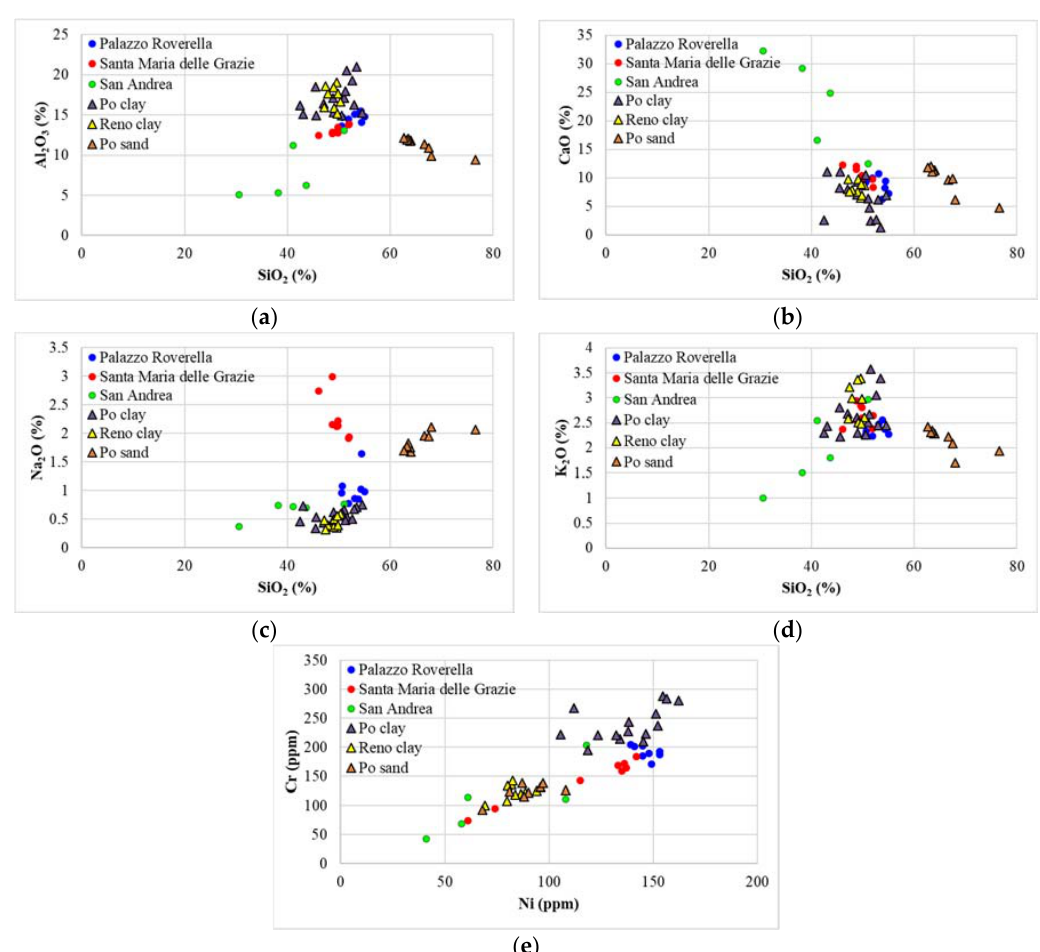
Figure 7. Binary diagrams on the XRF data comparing the data of clays from the Reno river and of clays and sands from the Po river [45]: ( a ) Al 2 O 3 -SiO 2 ; ( b ) CaO-SiO 2 ; ( c ) Na 2 O-SiO 2 ; ( d ) K 2 O-SiO 2 ; ( e ) Ni-Cr.